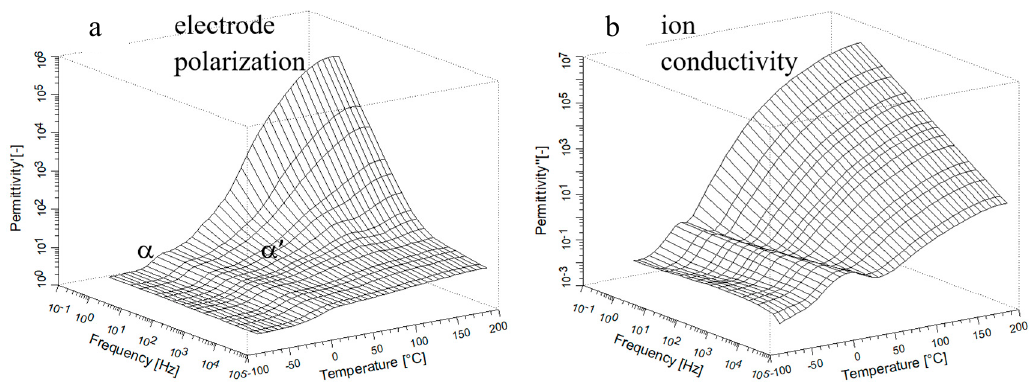
Figure 4. Frequency and temperature dependence of: ( a ) the real (permittivity’) and ( b ) imaginary (permittivity”) permittivity for vulcanizate crosslinked with ZnO/SiO 2 (sample called X20mS).